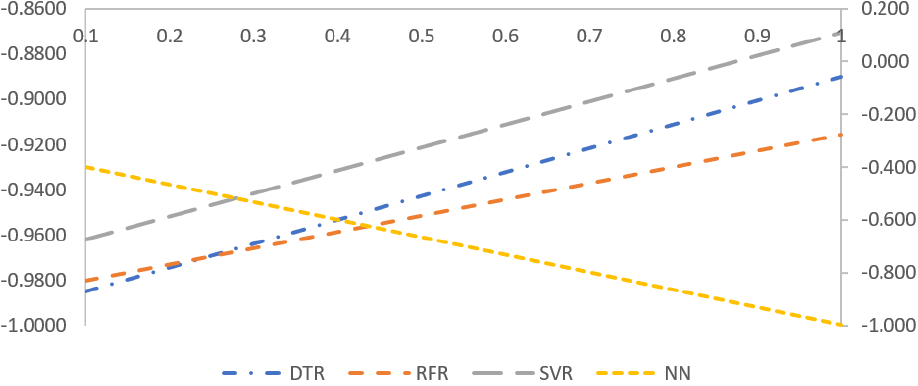
Figure 1. Sensitivity Analysis of Accuracy and Time significance weights.